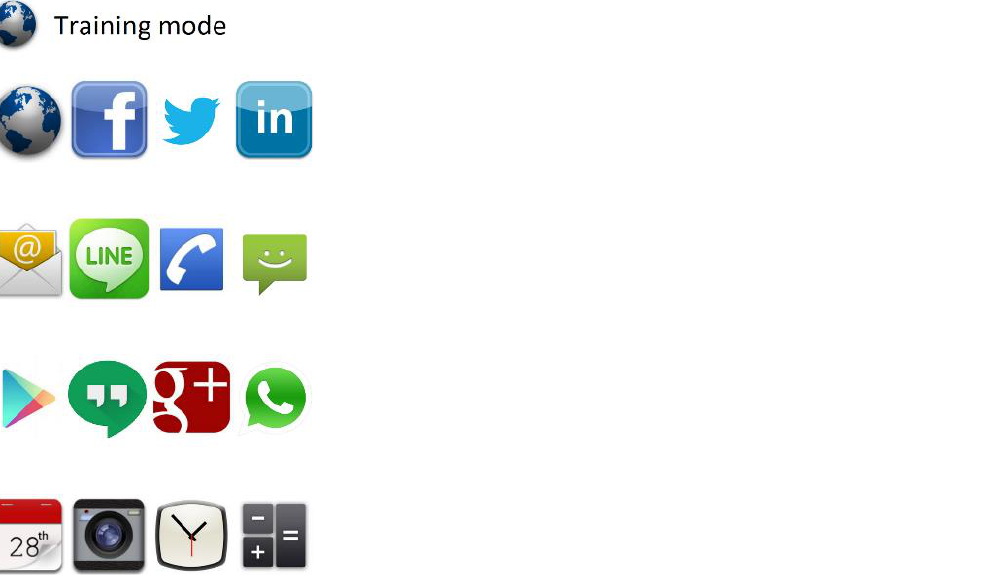
Figure 3. Training section screen of the EXT application. A set of sixteen haptic icons is shown in a 4 × 4 grid.